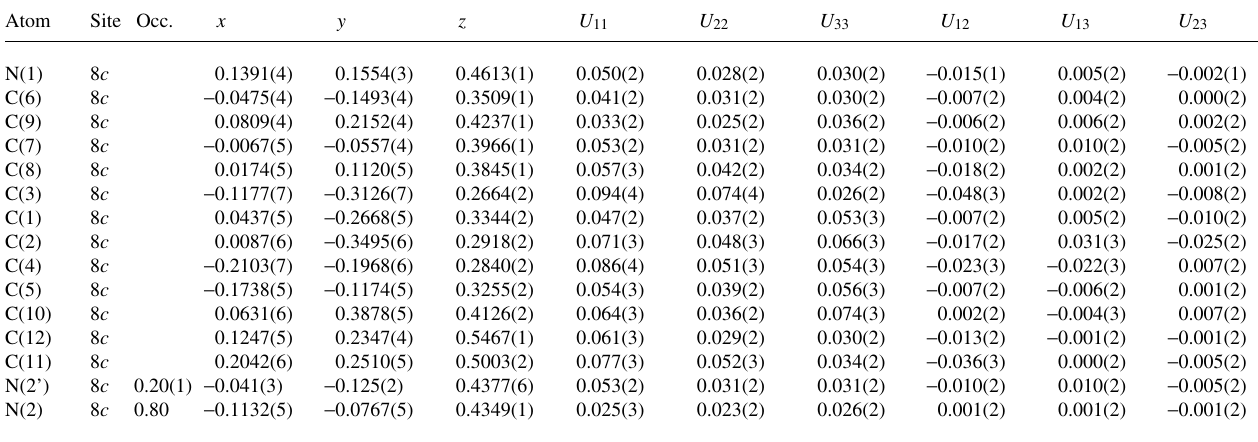
Table 3. Atomic coordinates and displacement parameters (in Å 2 )